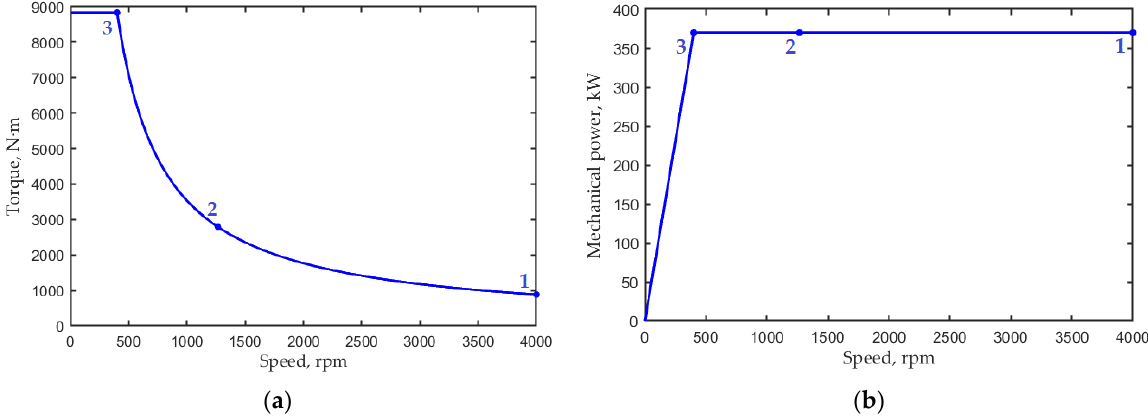
Figure 3. Traction characteristics of the motor. ( a ) Torque vs. rotational speed; ( b ) output mechanical power vs. rotational speed.